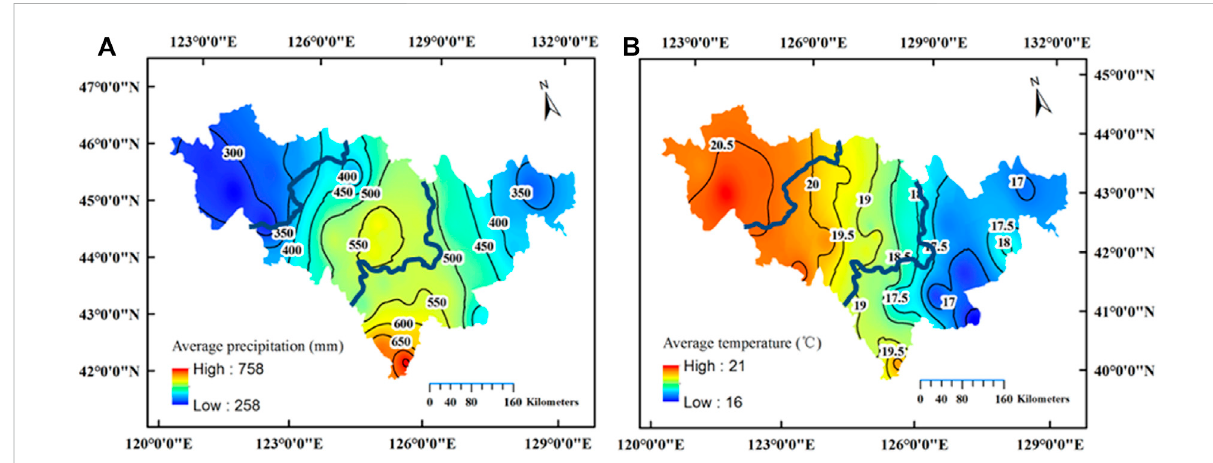
FIGURE 2 Spatial distribution of average precipitation (A) and temperature (B) during the growing season (May to September) from 1960 to 2012. Black lines are the boundaries of counties, and dark-blue lines are the boundaries of the eastern humid mountainous area (EHMA), central semi-humid plain area (CSPA), and western semi-arid plain area